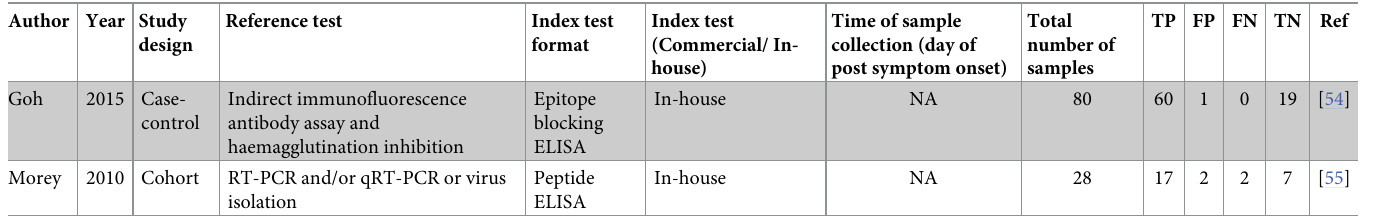
Table 4. Characteristics of studies on neutralising antibodies detection